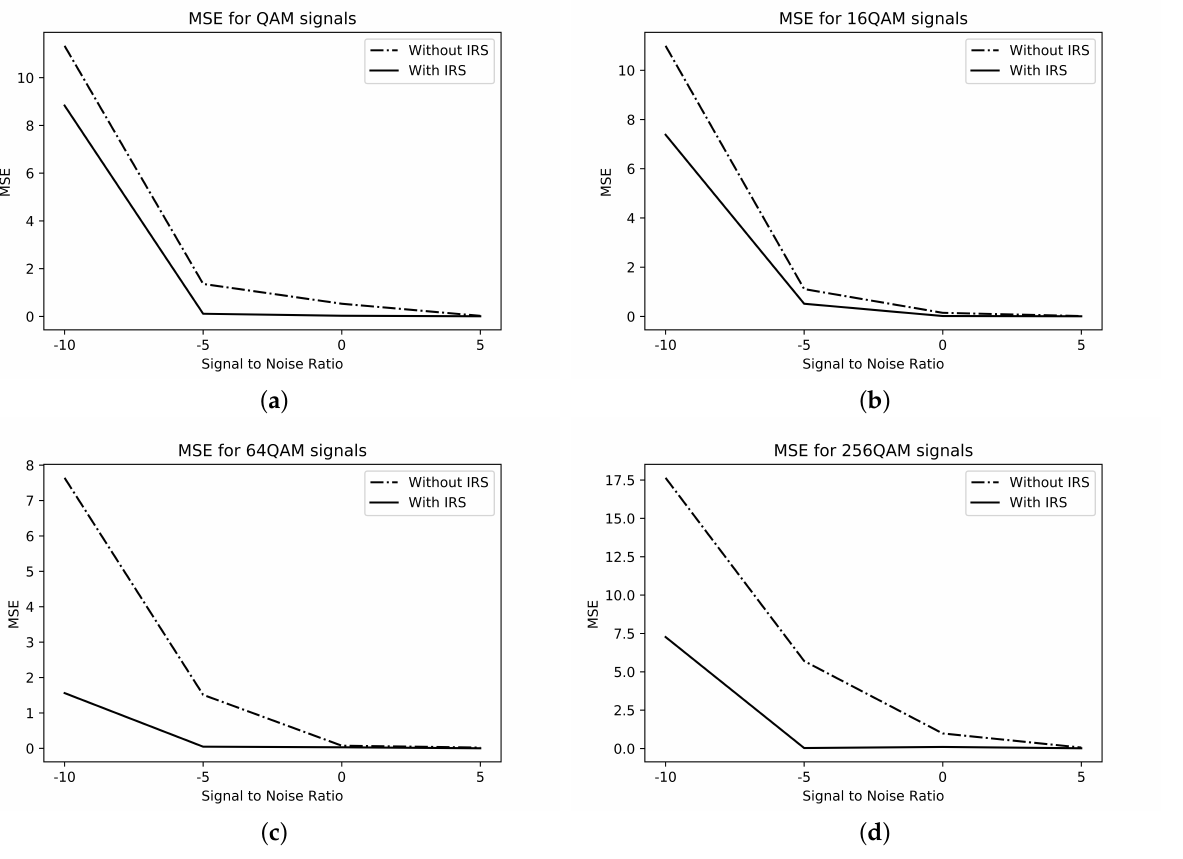
Figure 5. MSE for M-QAM signals. ( a ) QAM; ( b ) 16-QAM; ( c ) 64-QAM; ( d )